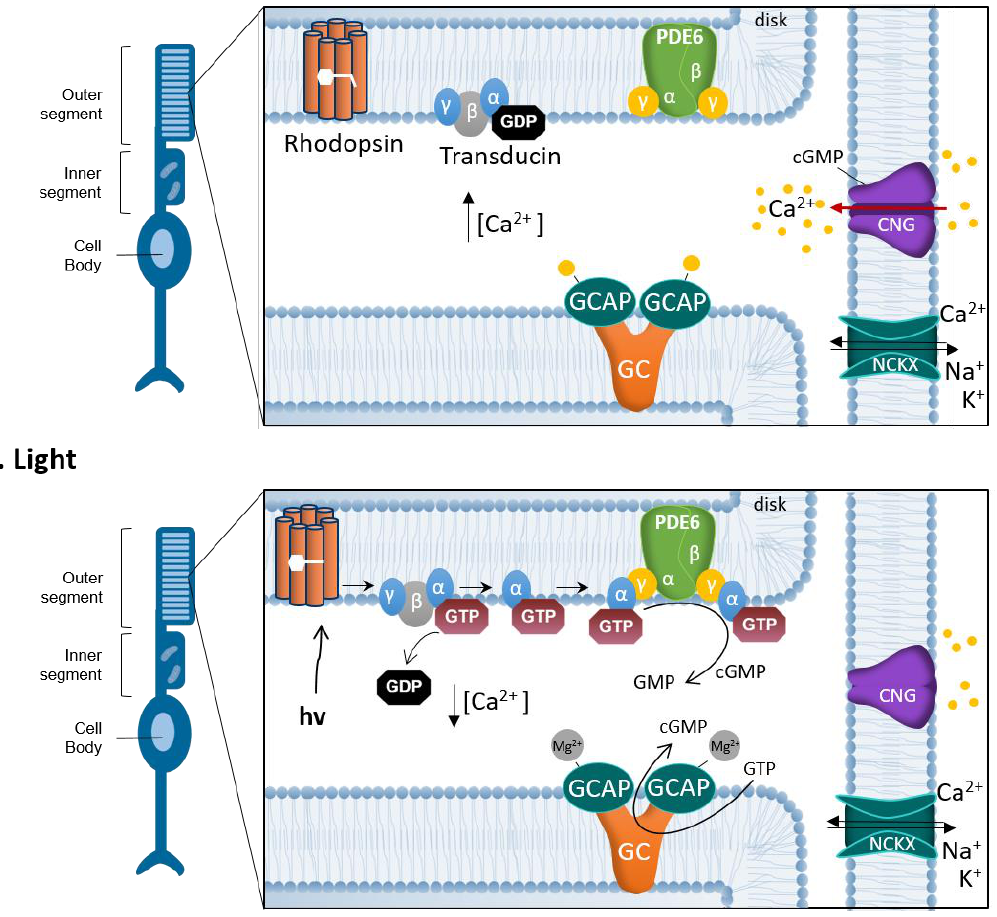
Figure 2. Phototransduction and the photoreceptor cGMP-Ca 2+ feedback loop. Schematic representation of the interplay between cGMP and Ca 2+ in the photoreceptor outer segment (OS). ( A ) In darkness, cGMP binds to the cyclic nucleotide-gated channel (CNGC). The opening of CNGC allows for an influx of Na + and Ca 2+ into the photoreceptor OS. At the same time K + and Ca 2+ ions are constantly extruded via Na + /Ca 2+ /K + exchanger (NCKX) creating a continuous influx and outflow of ions called the dark current. Ca 2+ binds GC activating proteins (GCAPs), which inhibit the synthesis of cGMP by limiting guanylyl cyclase (GC) activity. ( B ) In light, photon (hν) absorption induces conformational changes in the rhodopsin protein. Rhodopsin stimulates the GTP-binding protein transducin to detach from heteromeric G-protein complex, by replacing bound GDP with GTP. The activated transducin α subunit binds to the PDE6 complex, abolishing the inhibitory effect exerted by its γ subunits. Activated phosphodiesterase-6 (PDE6) hydrolyses cGMP to GMP, which in turn limits